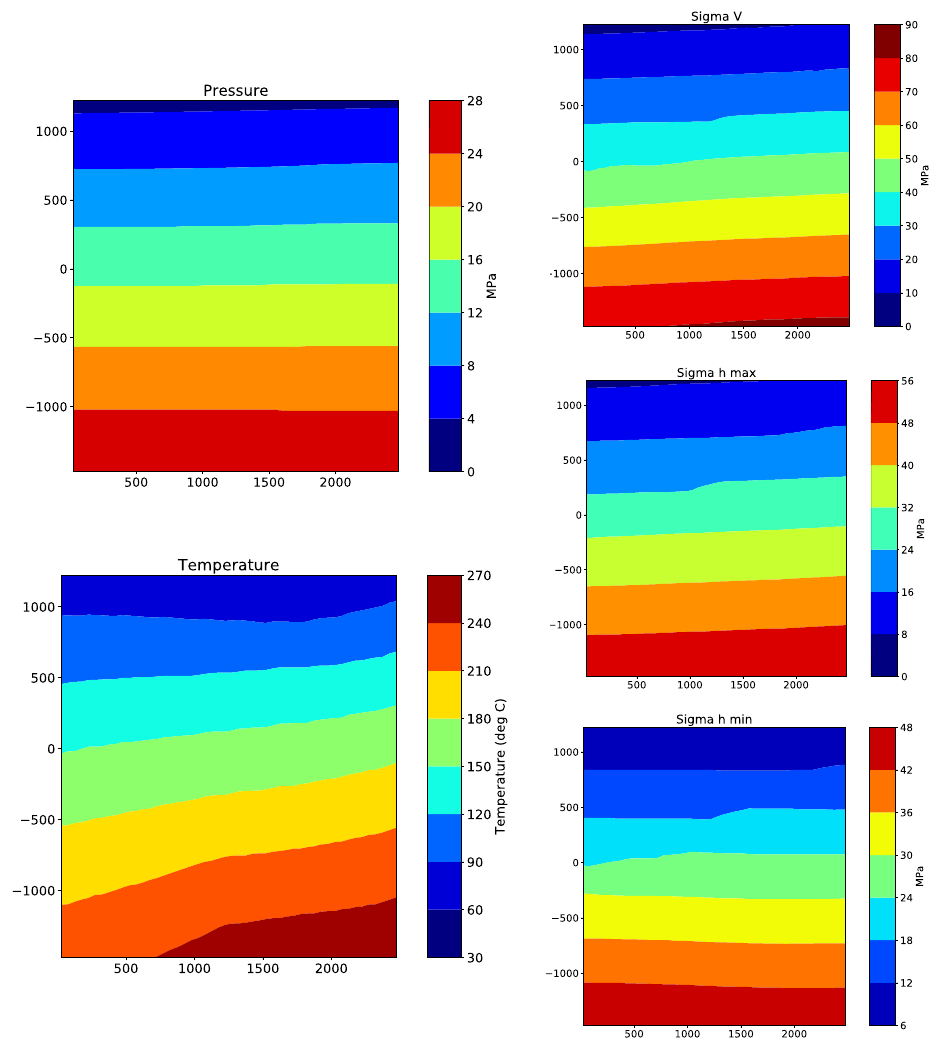
Figure 16. Predicted pressure, temperature, and stress along the planned trajectory for Well